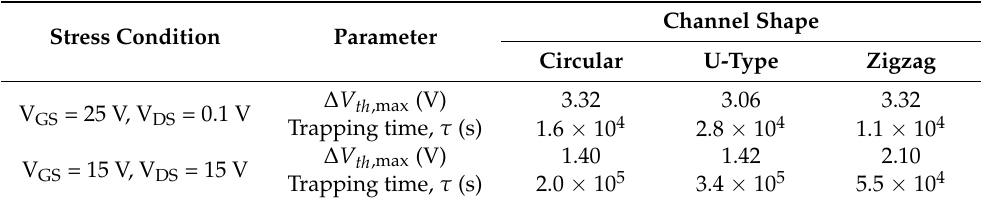
Table 1. Summary of ∆ V th and trapping time extracted from stretched exponential equation for 3-types a-IGZO